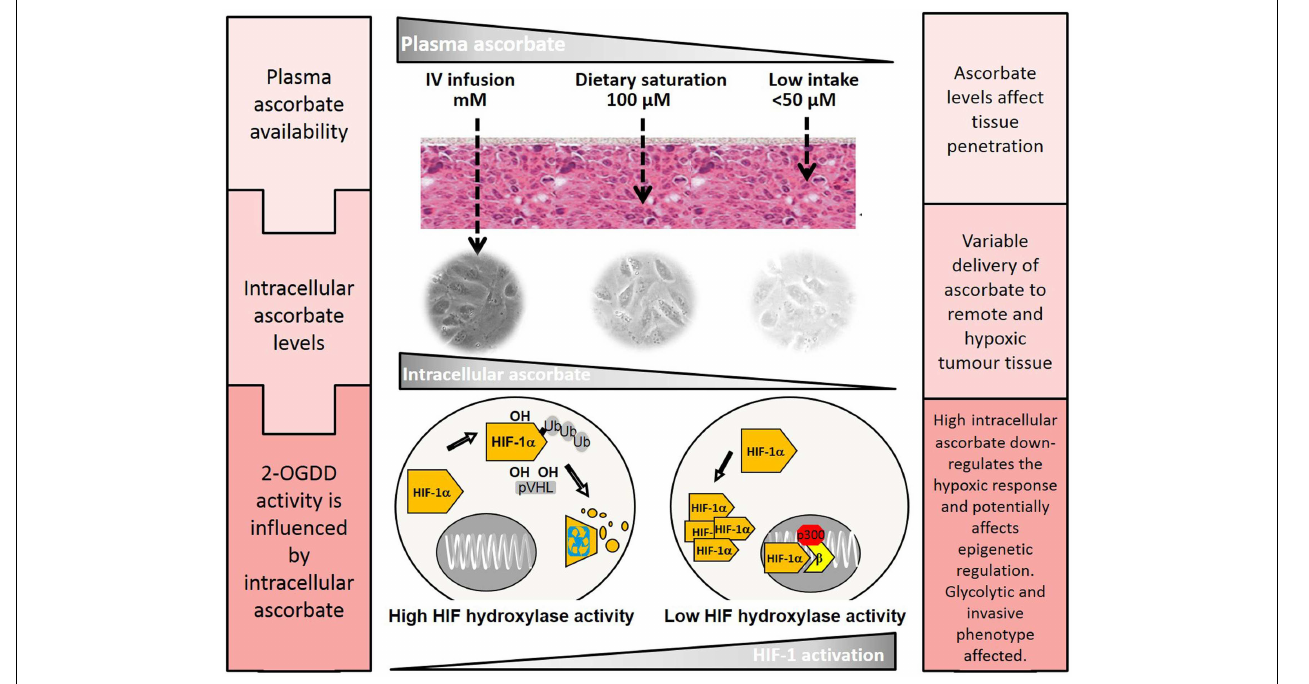
glycolytic phenotype, cell survival pathways, and angiogenesis could be affected, decreasing tumor viability and improving treatment outcomes. The epigenetic demethylases that also belong to the 2-OGDD family are also likely to be affected but little is known about these processes in cancer